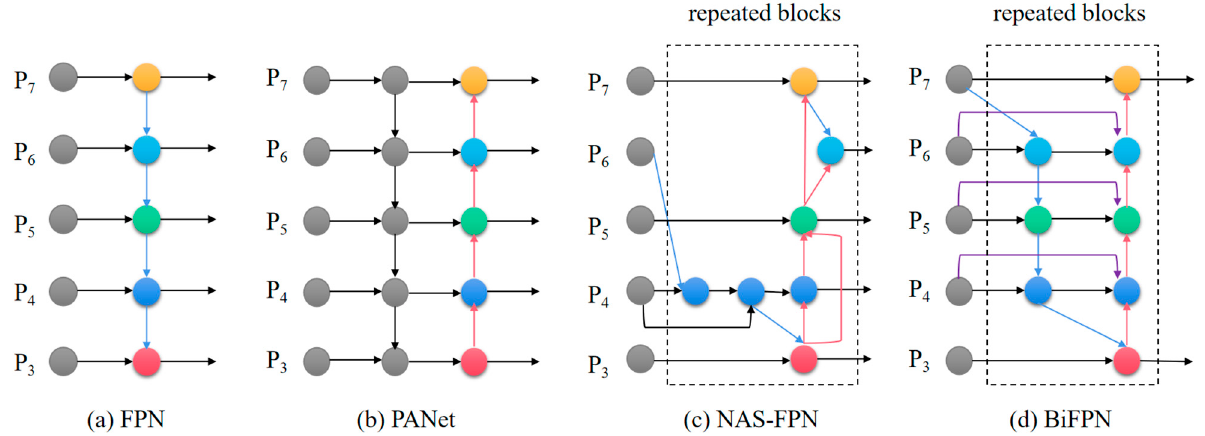
Figure 5. Structure Comparison of BiFPN Module and Other Feature Fusion Modules.